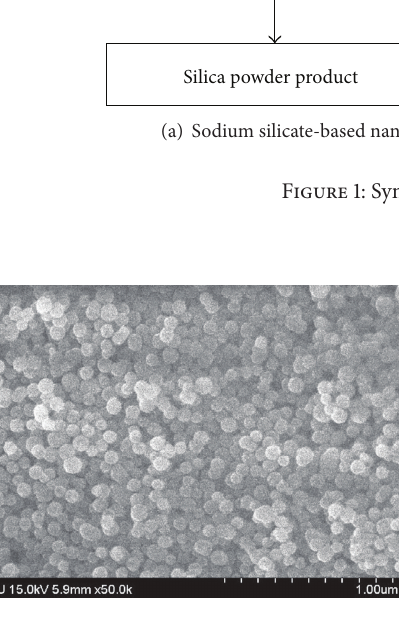
Figure 2: SEM micrograph of sodium silicate-based nanosilica ( × 50k).